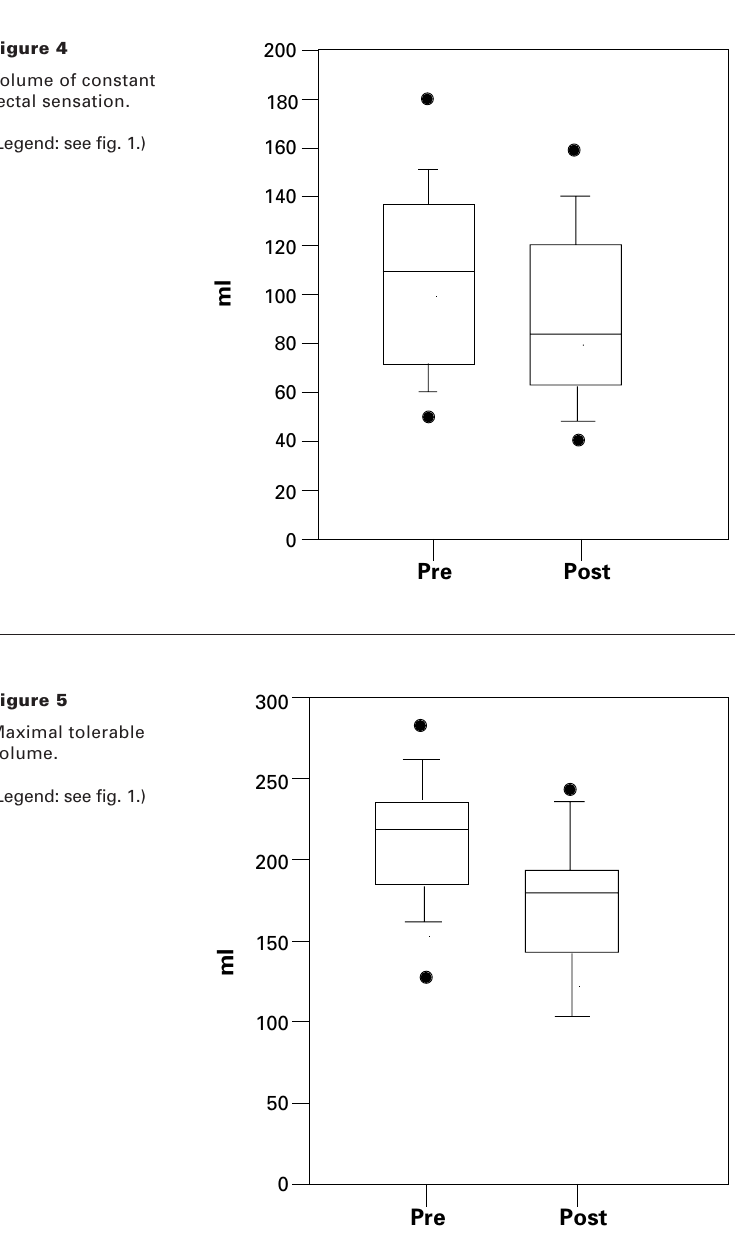
Volume of constant rectal sensation.